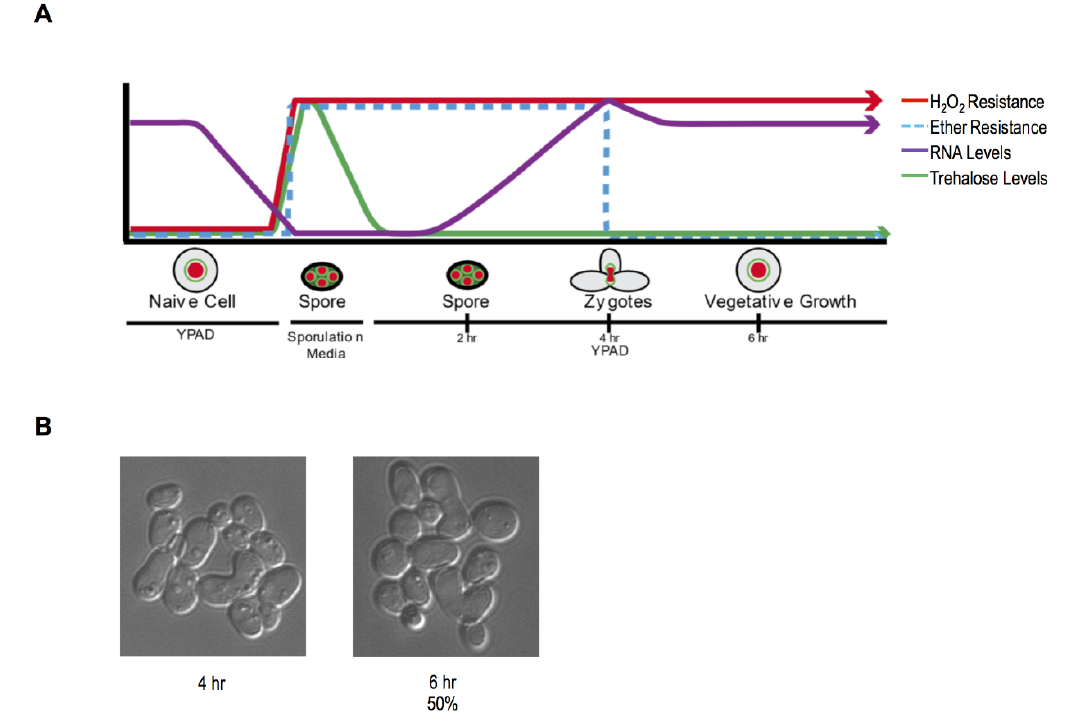
FIGURE 2: Developmental transitions and cellular memory of germinating cells. (A) A diagram depicting the changes in observed H 2 O 2 , ether resistance, trehalose accumulation, and extractable RNA levels through sporulation and germination is shown. (B) Representative pictures of germinating cells in YPD media at 4 and 6-hour time points. At the 6-hr time point 1 OD doubling was measured via a spectrometer and ~50% of cells were zygotes as determined by microscopic